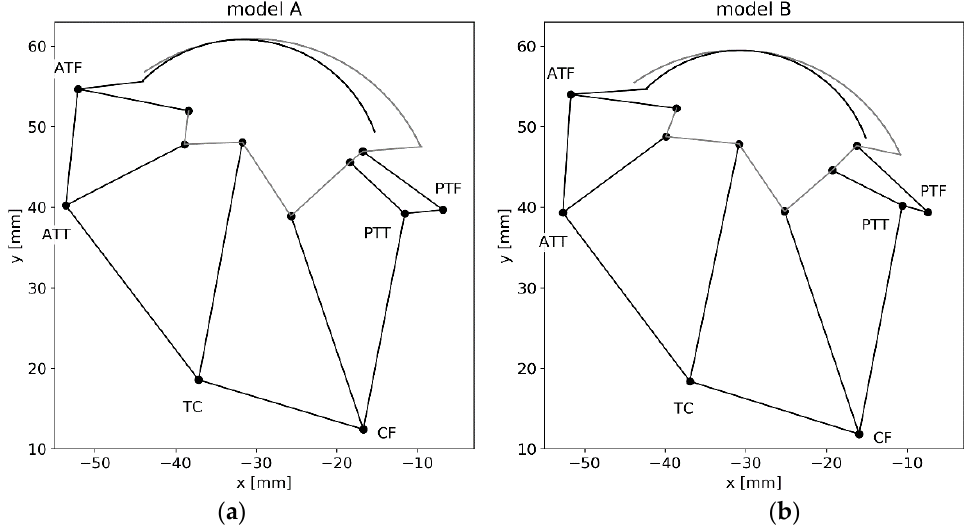
Figure 6. Two adversarial structures obtained with the algorithm for the ankle joint model (as seen in the prepared software). Only relevant parts of the contours of the bone segments were drawn. ( a ) Model A; ( b ) model B.